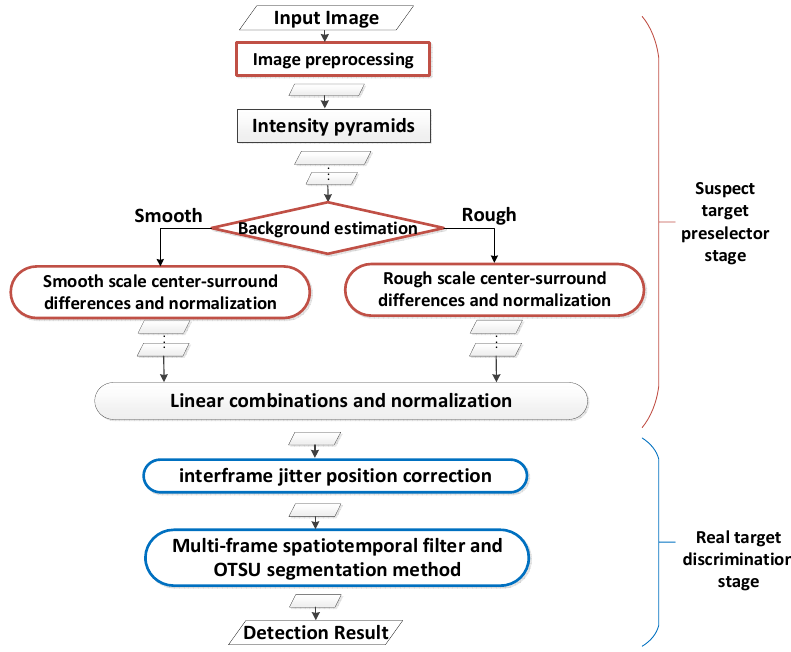
Figure 9. Overall structure and flow of the proposed